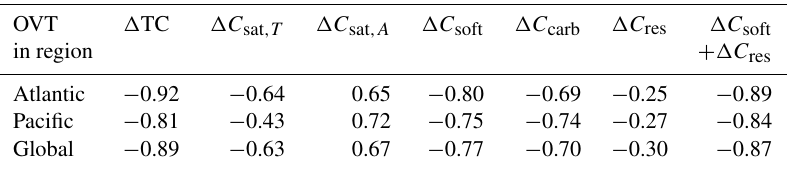
Table 4. Correlation coefficients of the changes in OVT (see Sect. 3.4) sorted by geographical regions and the anomaly in each carbon species for the SE ensemble (relative to PIES278). OVT